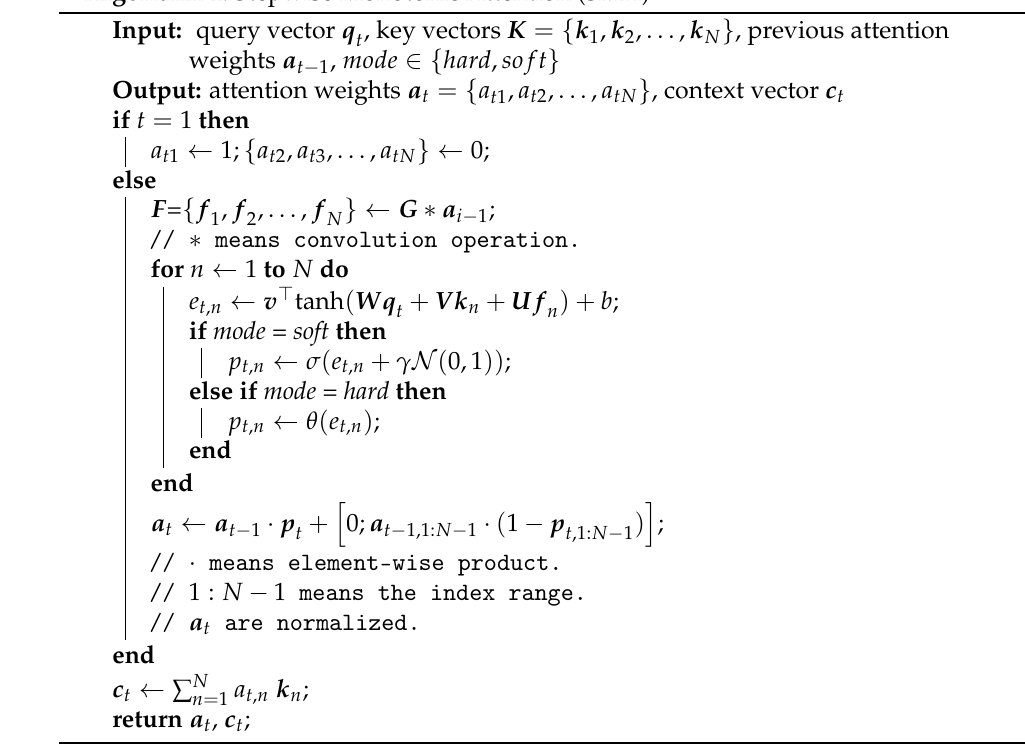
Algorithm 1: Stepwise Monotonic Attention